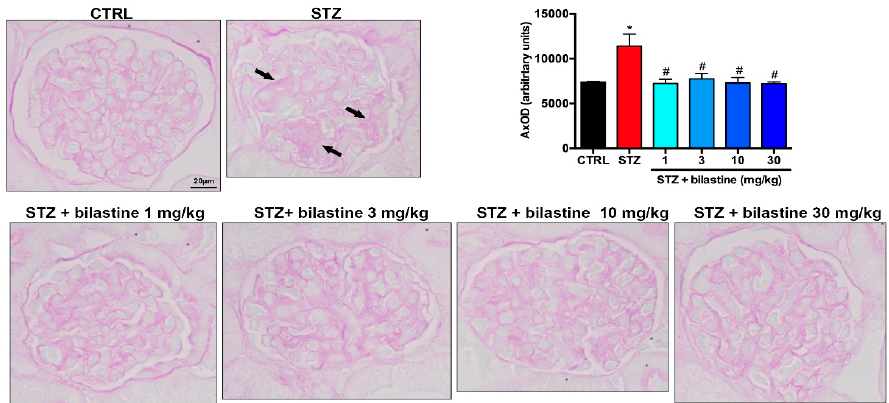
Figure 3. Effect of bilastine on glomerular morphology. Representative micrographs at 100× magnification of PAS stained renal sections. Arrows highlight mesangial matrix expansion. The image is representative of 20 microscopic fields/specimen and 10 animals/group. The densitometric analysis is expressed as the mean ± S.E.M. ( n = 10); * p < 0.05 vs. CTRL; # p < 0.05 vs. STZ. Int. J. Mol. Sci. 2019 , 20 , x FOR PEER REVIEW